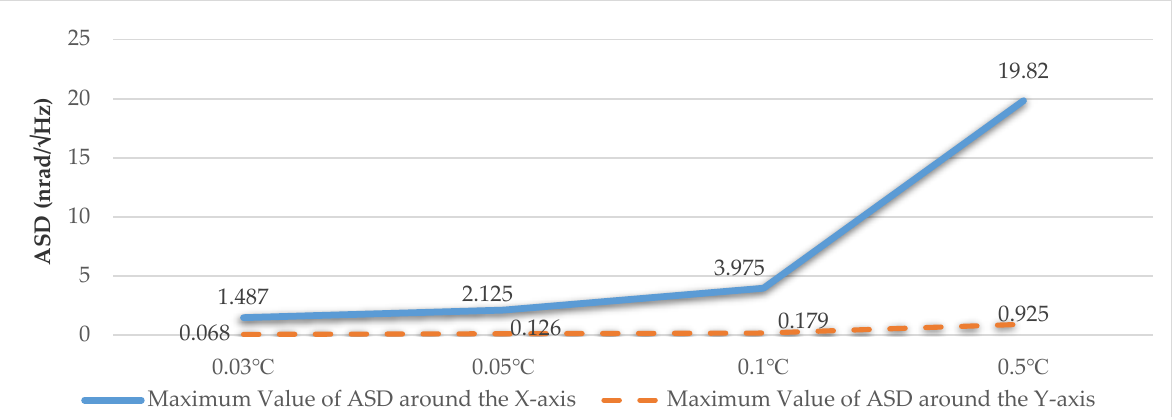
Figure 5. Amplitude spectral density (ASD) corresponding to four temperature variation functions: ( a ) 0.03 °C; ( b ) 0.05 °C; ( c ) 0.1 °C; ( d ) 0.5 °C.